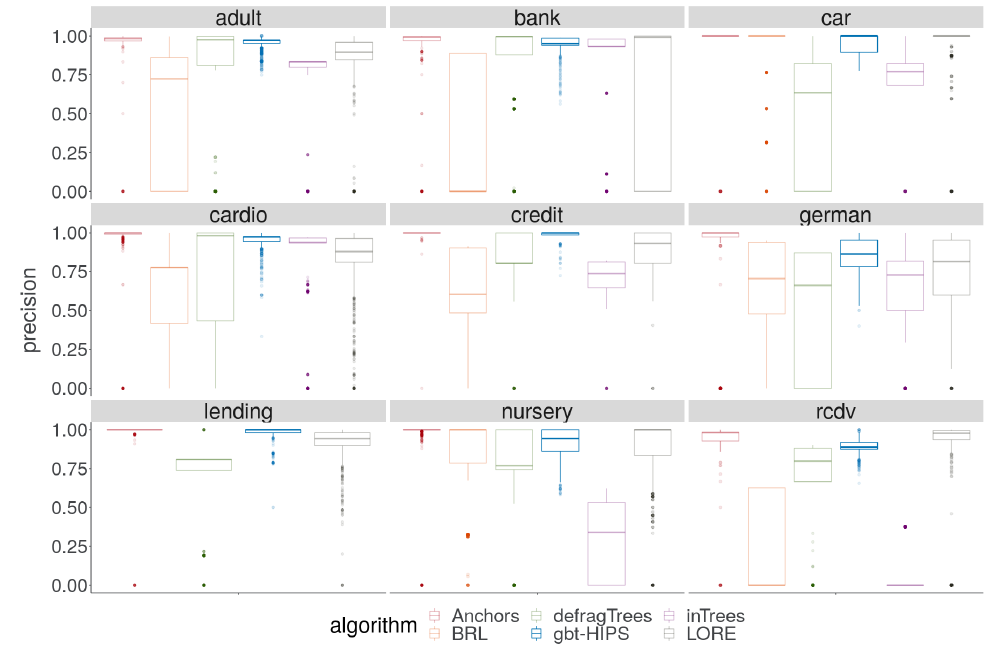
Figure 5. Distribution of precision for stochastic GBT model